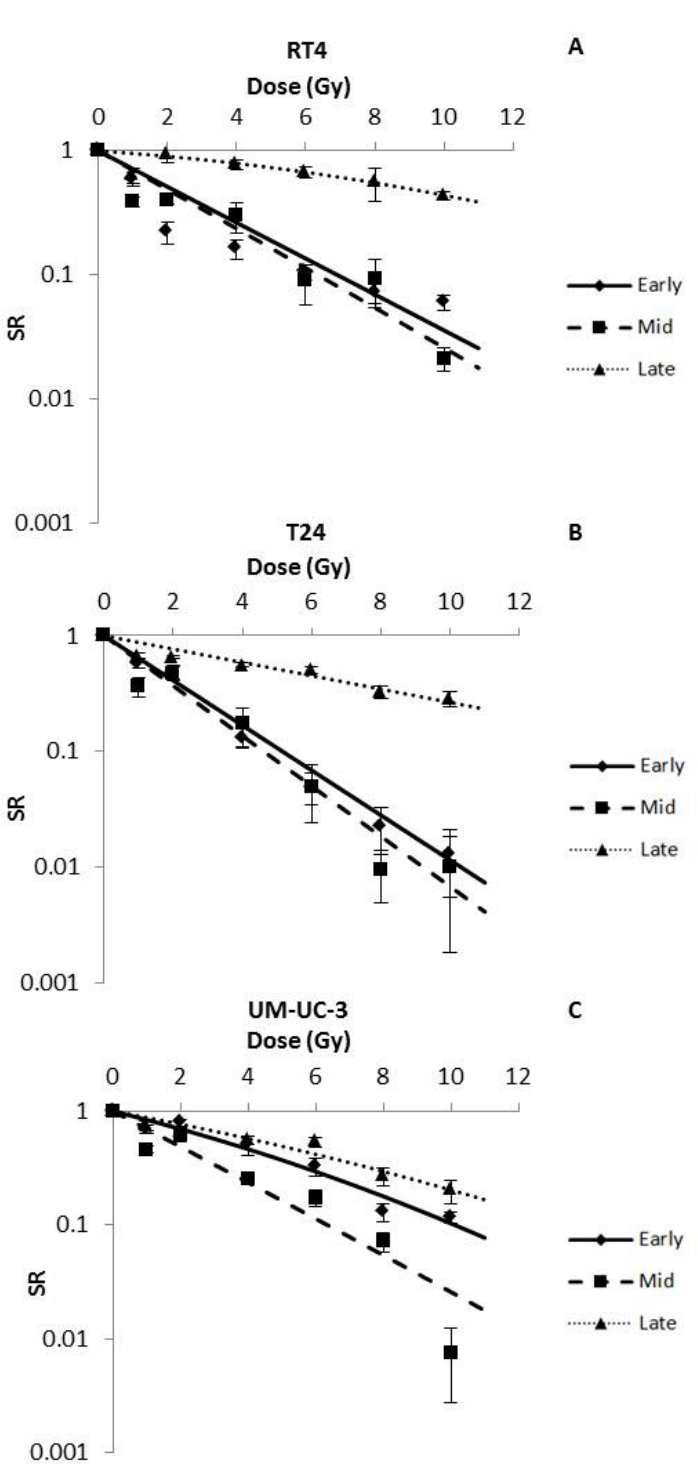
Figure 3. Radio-induced decrease in the sphere ratio (SR) for RT4 ( A ), T24 ( B ) and UM-UC-3 ( C ) after performing early, mid and late treatment protocols. Data represents the mean of at least three independent experiments ± SEM. Data are fitted to the Linear-Quadratic (LQ) equation (Equation (2)). Fitting parameters and the corresponding R 2 values are shown in Table 3. Sphere images are shown in Figures S1–S3.